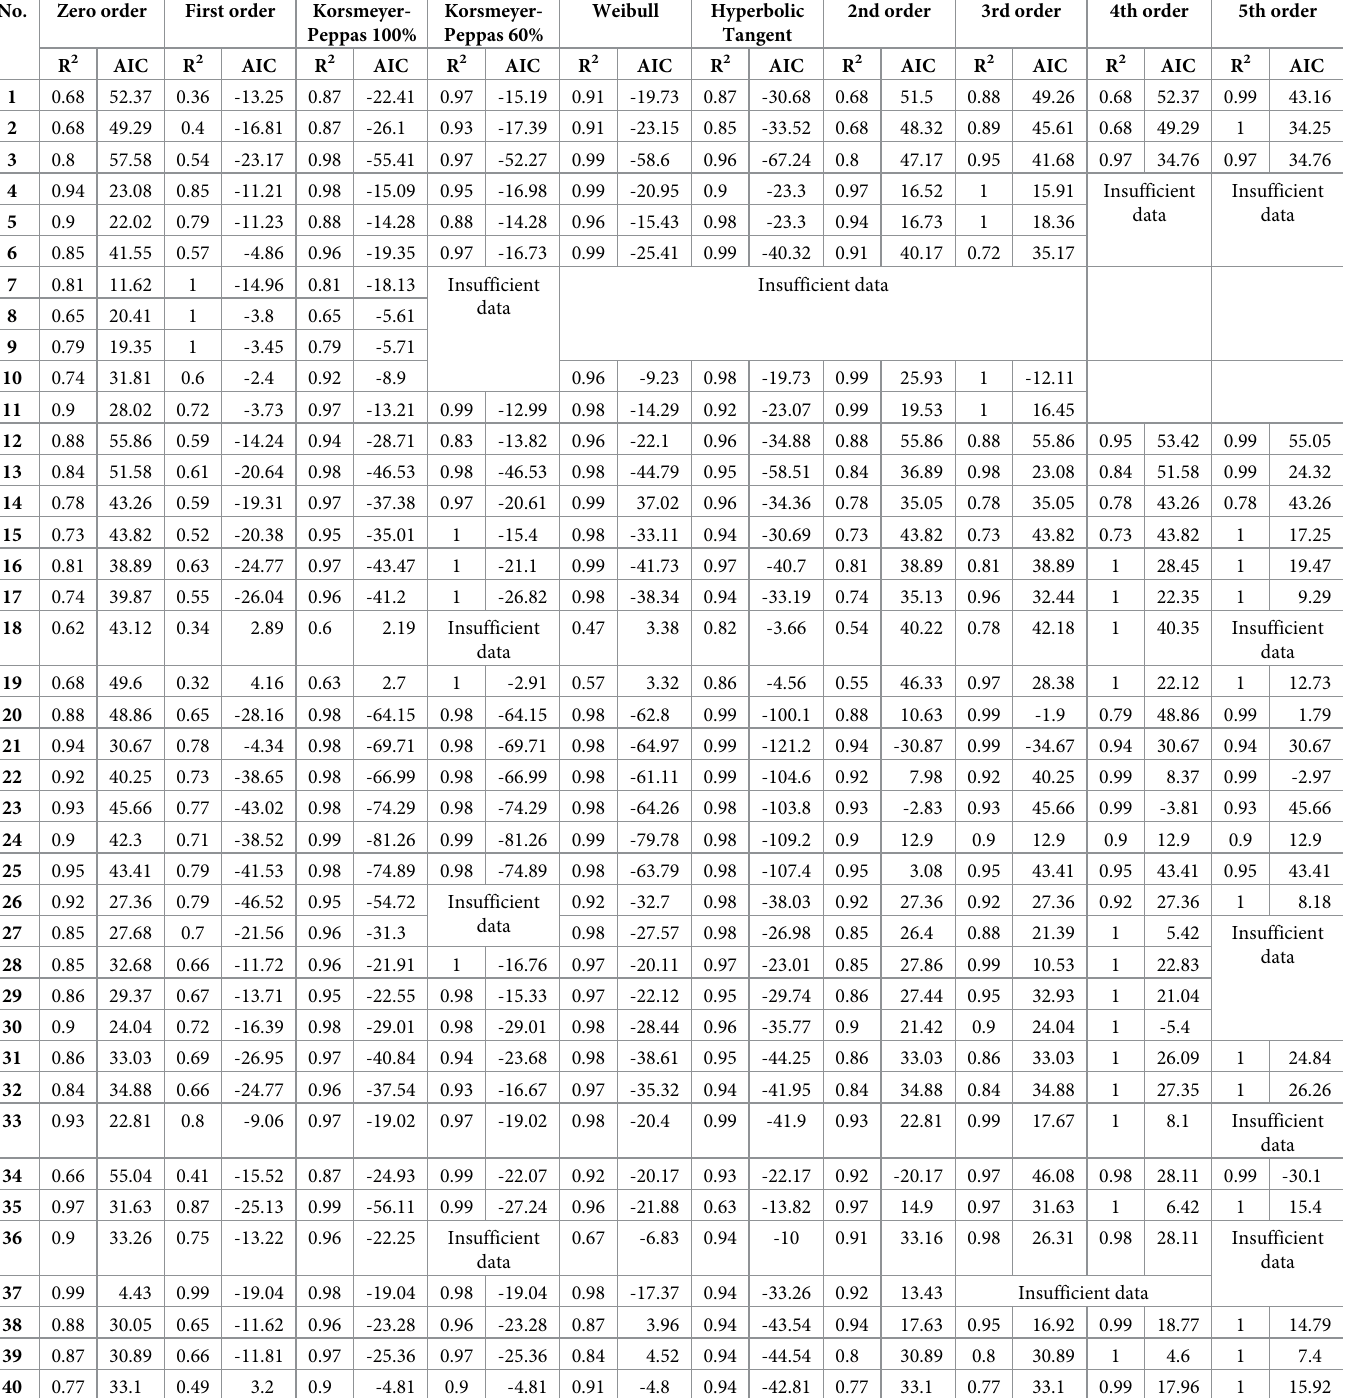
Table 5. Comparison of R 2 and AIC criteria of data sets using Bootstrap resampling of empirical/semiempirical models and polynomial equations.